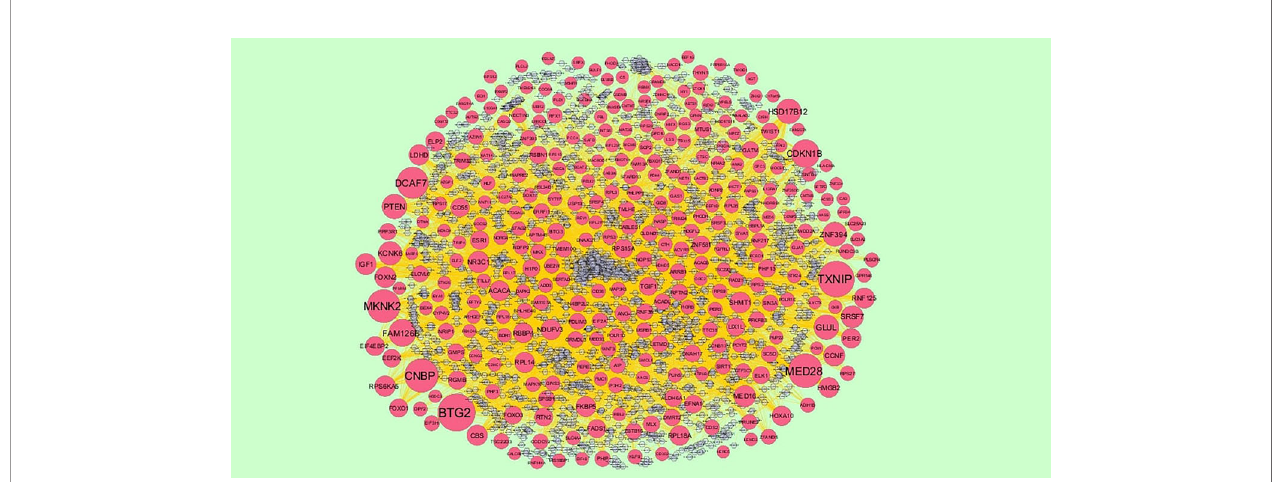
FIGURE 8 | The network of down regulated genes and their related miRNAs. The red circles nodes are the down regulated genes, and chocolate diamond nodes are the miRNAs.